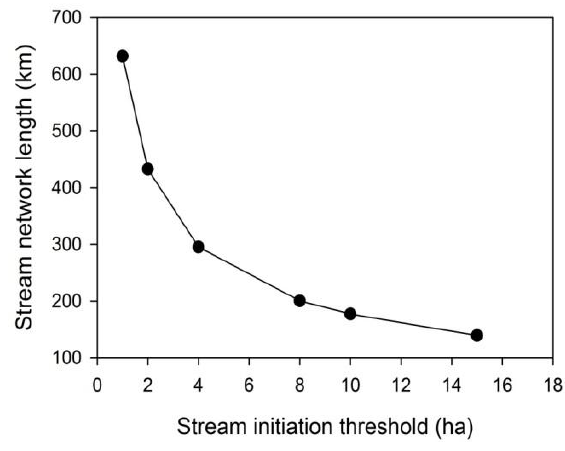
Figure 4. The stream network length for the Krycklan Catchment as a function of the stream initiation threshold